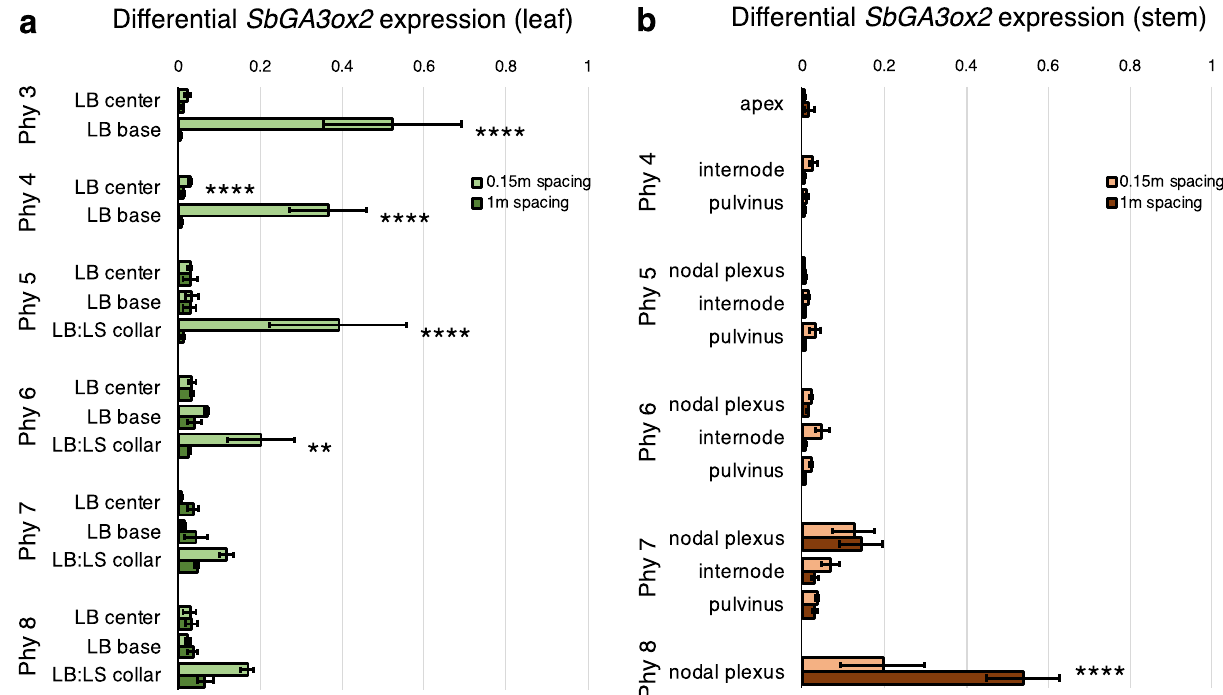
Figure 6. GA3ox2 is differentially expressed at high vs. low plant spacing. ( a ) Differential expression of SbGA3ox2 in the leaf blade (LB) and leaf blade/leaf sheath collar tissue (LB:LS collar) of phytomers 3–8 of plants grown at 0.15 m spacing (high density) and 1 m spacing (low density). ( b ) Differential expression of SbGA3ox2 in the stem apex, nodal plexus, internode and pulvinus of plants grown at 0.15 m and 1 m spacing. Expression values are the average of three biological replicates. Differences in expression were analyzed by one-way ANOVA followed by Tukey comparison test. ****P < 0.0001, **P < 0.005. Error bars: